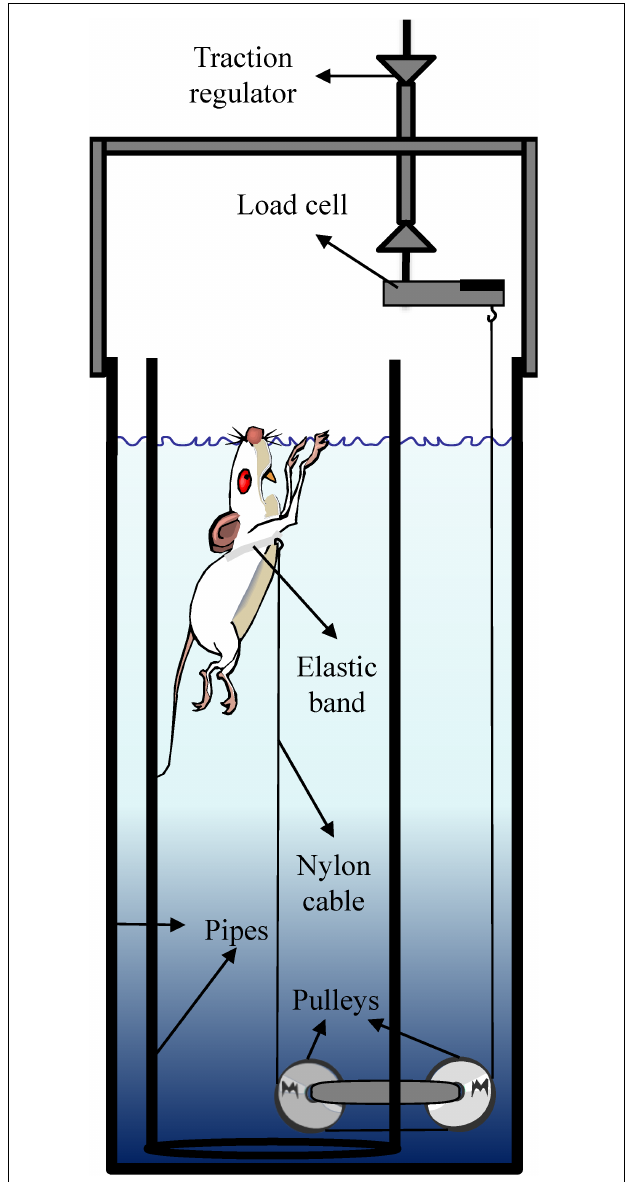
FIGURE 1 | Tethered swimming